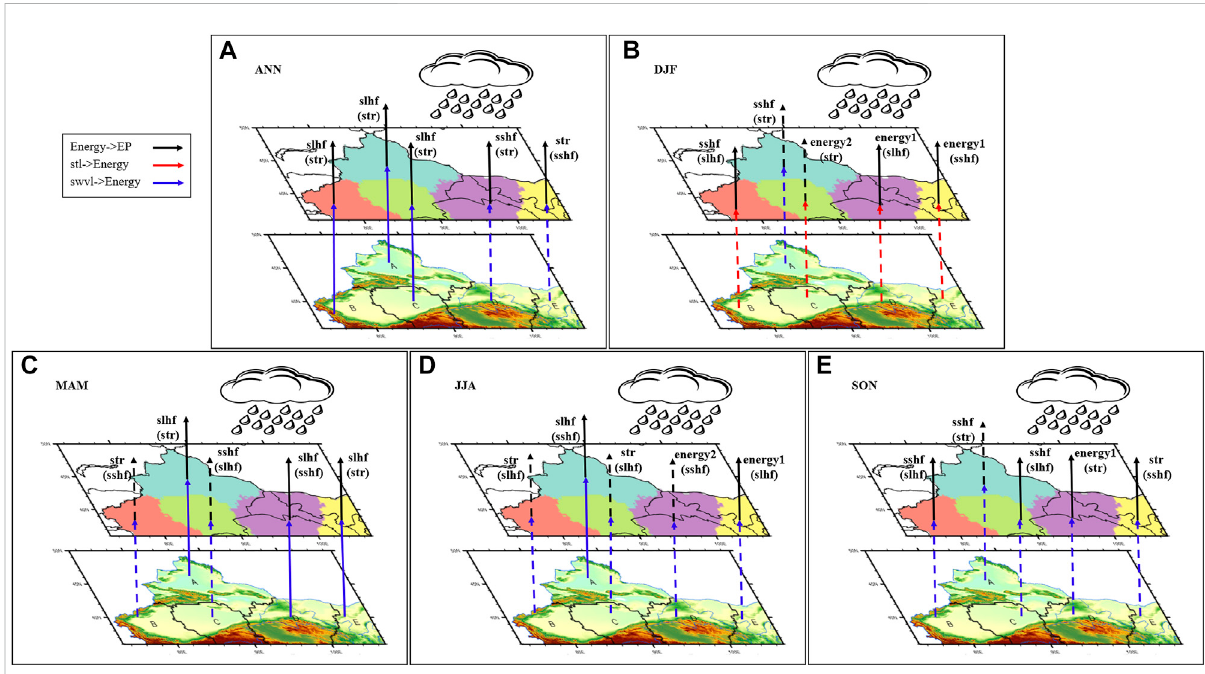
FIGURE 12 Two-step coupled paths throughout the year and seasons in the fi ve regions. In the fi gure, the most important energy contribution source of the path is shown next to the path arrow, the secondary contribution amount is in parentheses, the different color arrows represent the different feedback paths, and the dotted arrow indicates that the main energy coupling state of the path is